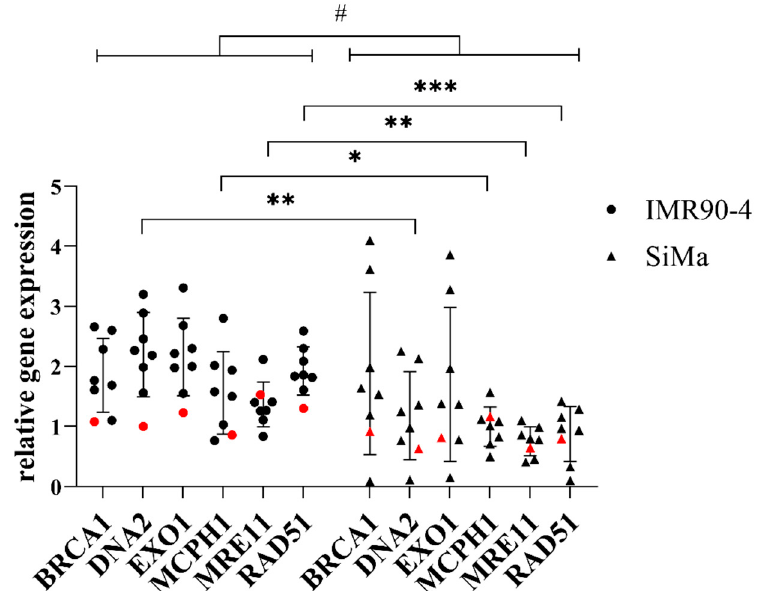
Figure 8. Relative gene expression of homology repair-deficiency-associated genes in IMR90-4 and SiMa clones. Expression calculated relative to non-transfected IMR90-4 and SiMa cells and reference genes PPIA and RPS23 . Values shown in red correspond to non-transfected IMR90-4 and SiMa clones. Values displayed as individual clones ± SD, n = 7. Statistical analysis: Unpaired t -test IMR90-4 vs. SiMa within individual genes: * = p < 0.05, ** = p < 0.01, *** = p < 0.001. Unpaired t -test IMR90-4 vs. SiMa all genes bundled: # = p < 0.05.